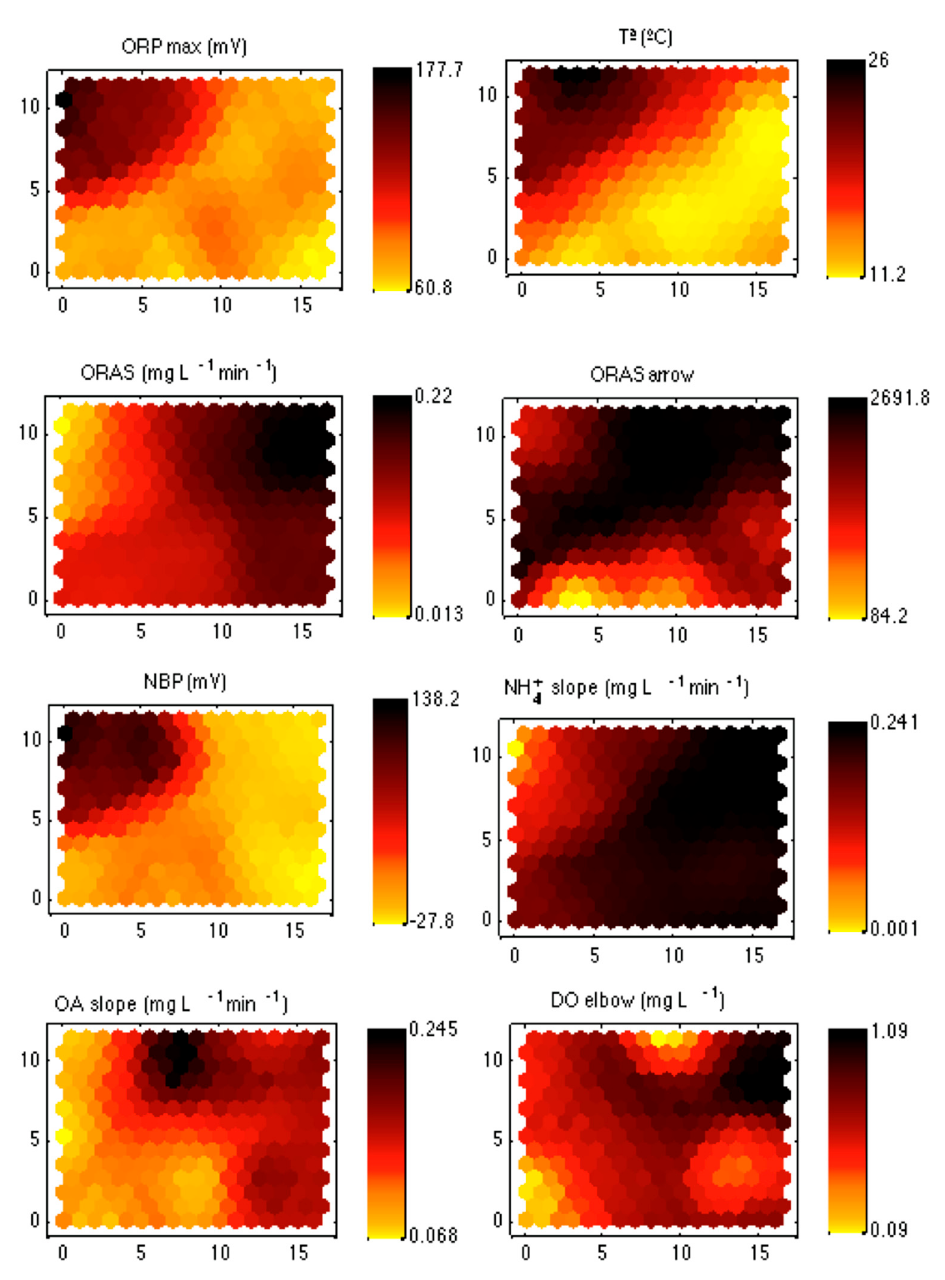
Figure 4. The 8 component maps corresponding to the parameters associated with the aeration-oxidation process.